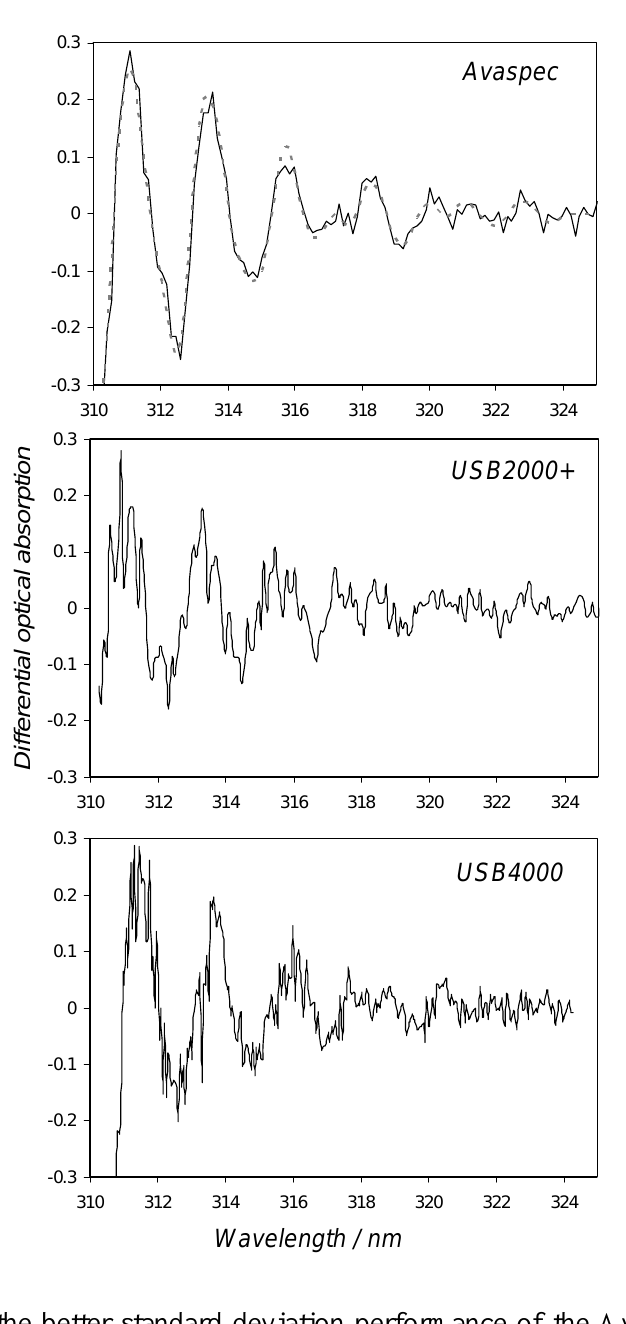
Figure 3. Differential absorption spectra, obtained from the 170 ms exposure time 1600 cell measurements with the Avaspec, USB2+E001, and the USB4000, in the ppmm SO 2 former case providing the best visual match to the scaled laboratory absorbance spectrum (dashed line in top